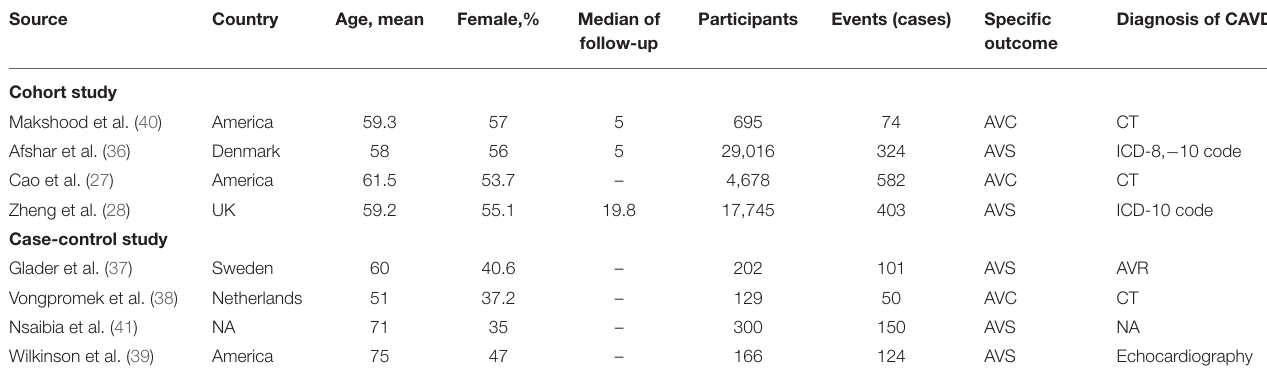
TABLE 1 | The characteristics of included